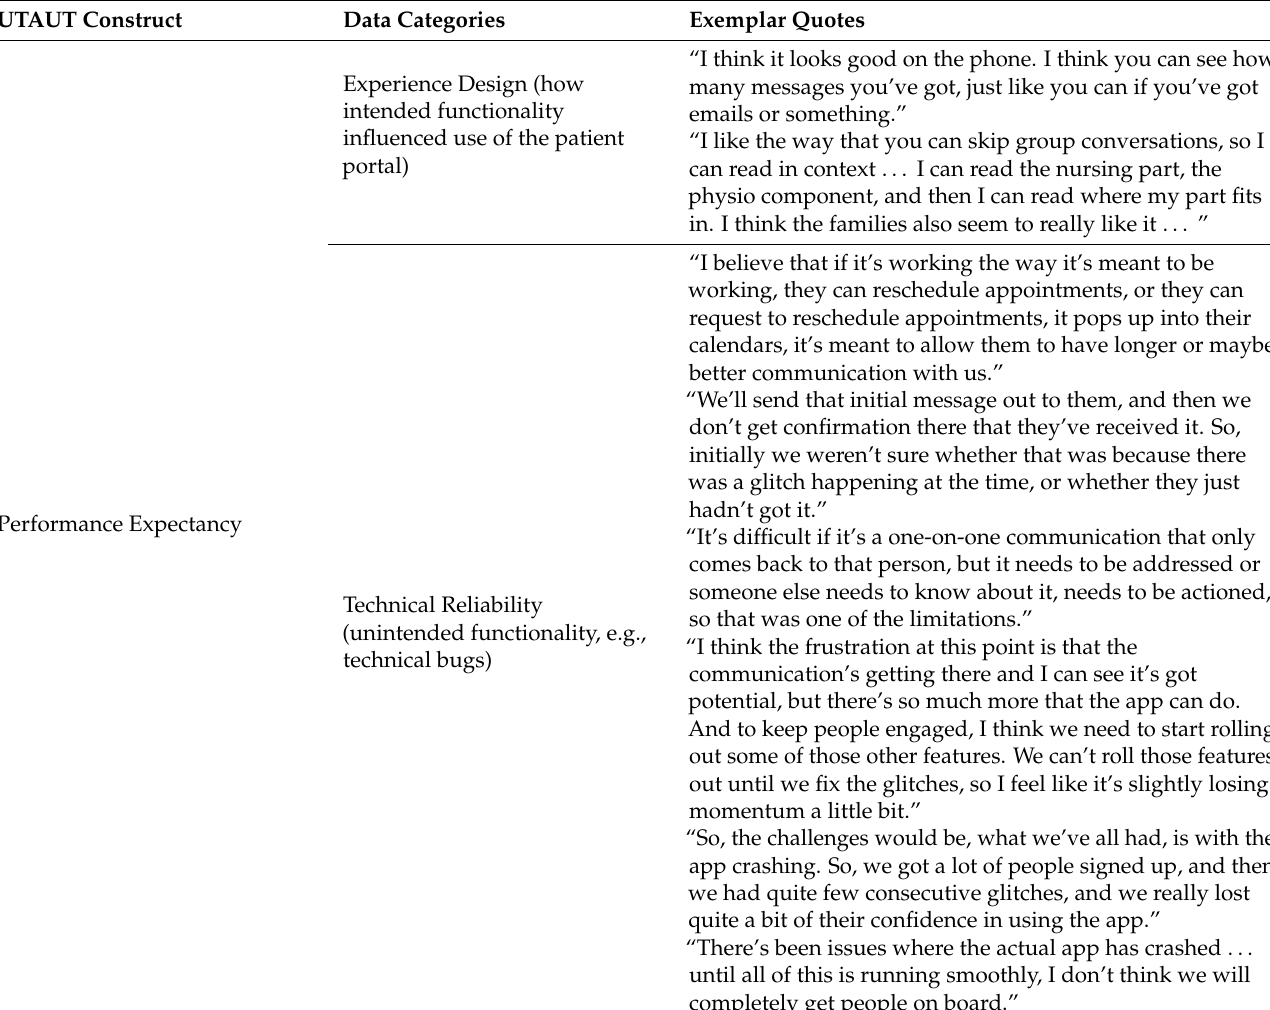
Table 1. Outline of how UTAUT (Unified Theory of Acceptance and Use of Technology) constructs aligned with sub- categories of data, aligned with exemplar